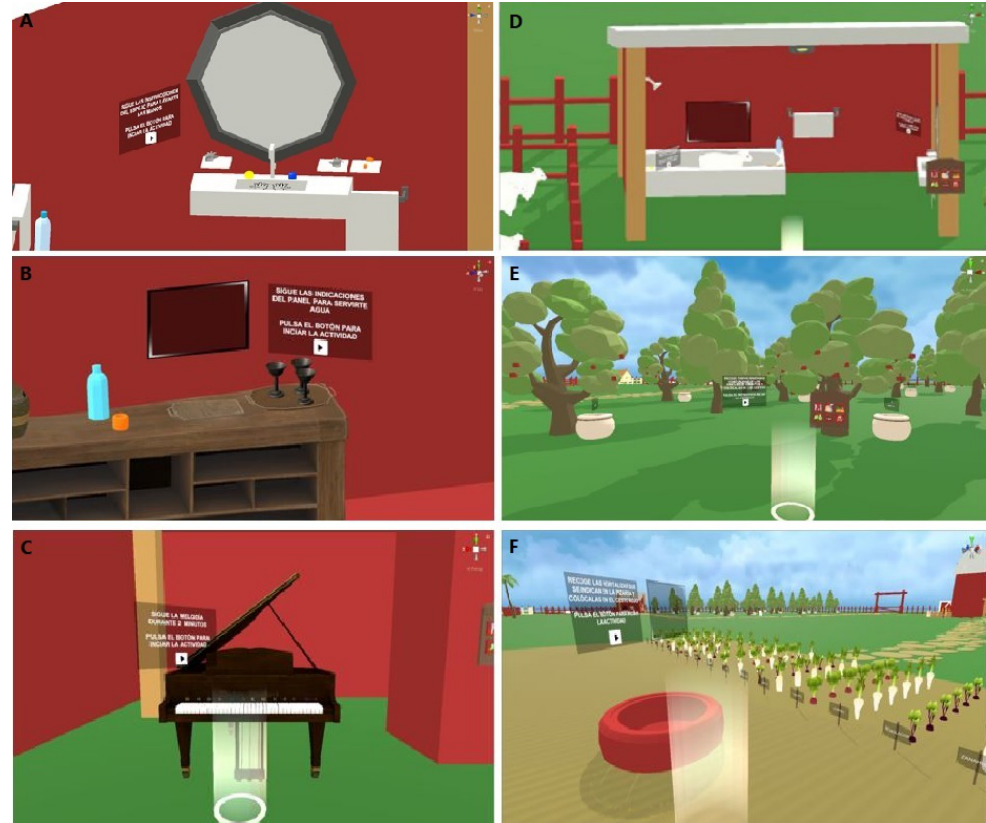
Figure 2. Virtual environments for the activities. ( A ) The cabin area for the hand-washing activity, consisting of a faucet, a mirror, and the interactive objects: gloves and soap. ( B ) The barn dinning area for the pouring a drink activity. ( C ) The interactive keyboard for the playing the piano activity. ( D ) The toilet cabin area for the animal caring activity. ( E ) The forest area for the picking apples from trees activity. ( F ) The orchard field area for the picking vegetables up off the ground activity. Table 1. Sequence of actions and the upper limb movements involved in the hand-washing activity. Action Upper Limb Movement Target ROM Shoulder flexion 90° Elbow extension 0° Turn on/off the faucet Elbow pronation